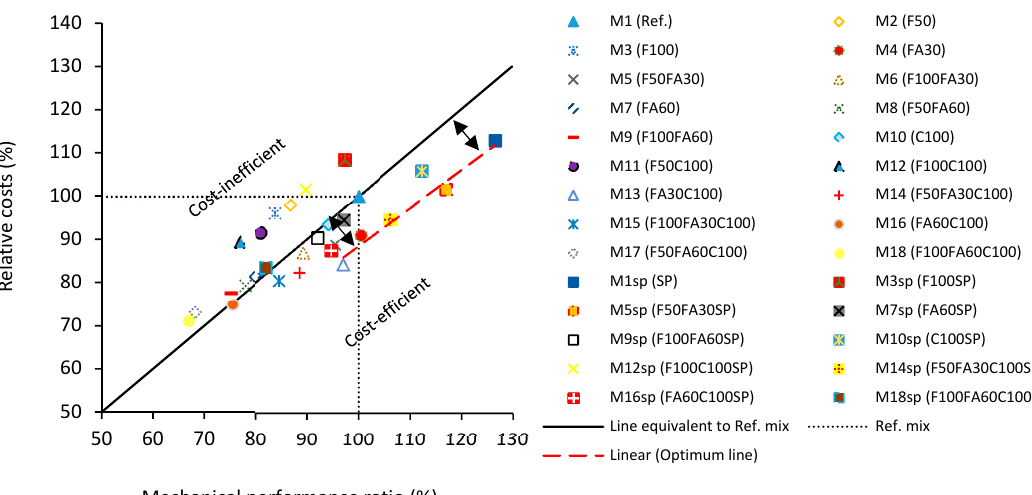
Figure 8. Relationship between relative cost and mechanical performance ratio of concrete mixes made with (square signs) and without (other signs) SP, regardless of the binders and aggregates used. FA, F, C, and SP stand for fly ash, fine RCA, coarse RCA, and superplasticizer, respectively, and the values are their incorporation level in the mixes.